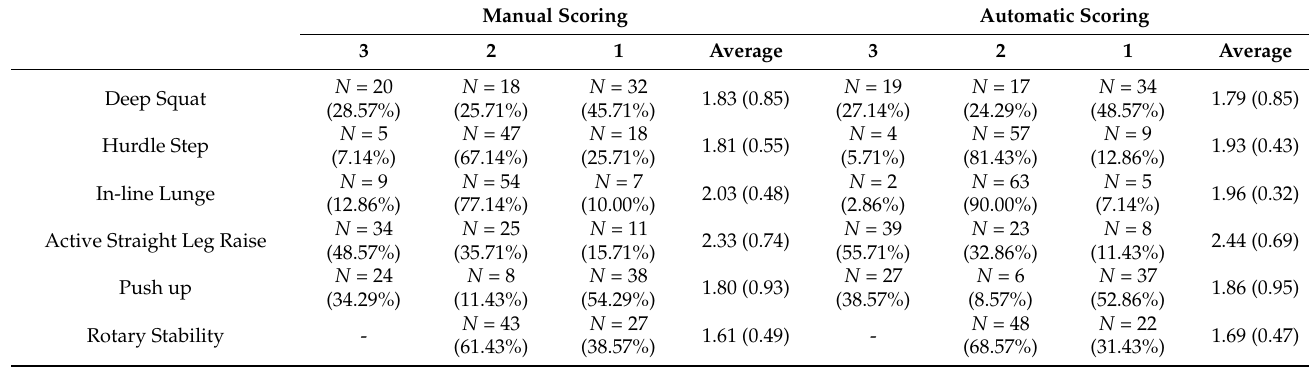
Table 3. The average scores of the six functional movement screen (FMS) tests graded by the professional athlete trainer and automatic grading system (mean ± SD) and the number and classification rate in each class.